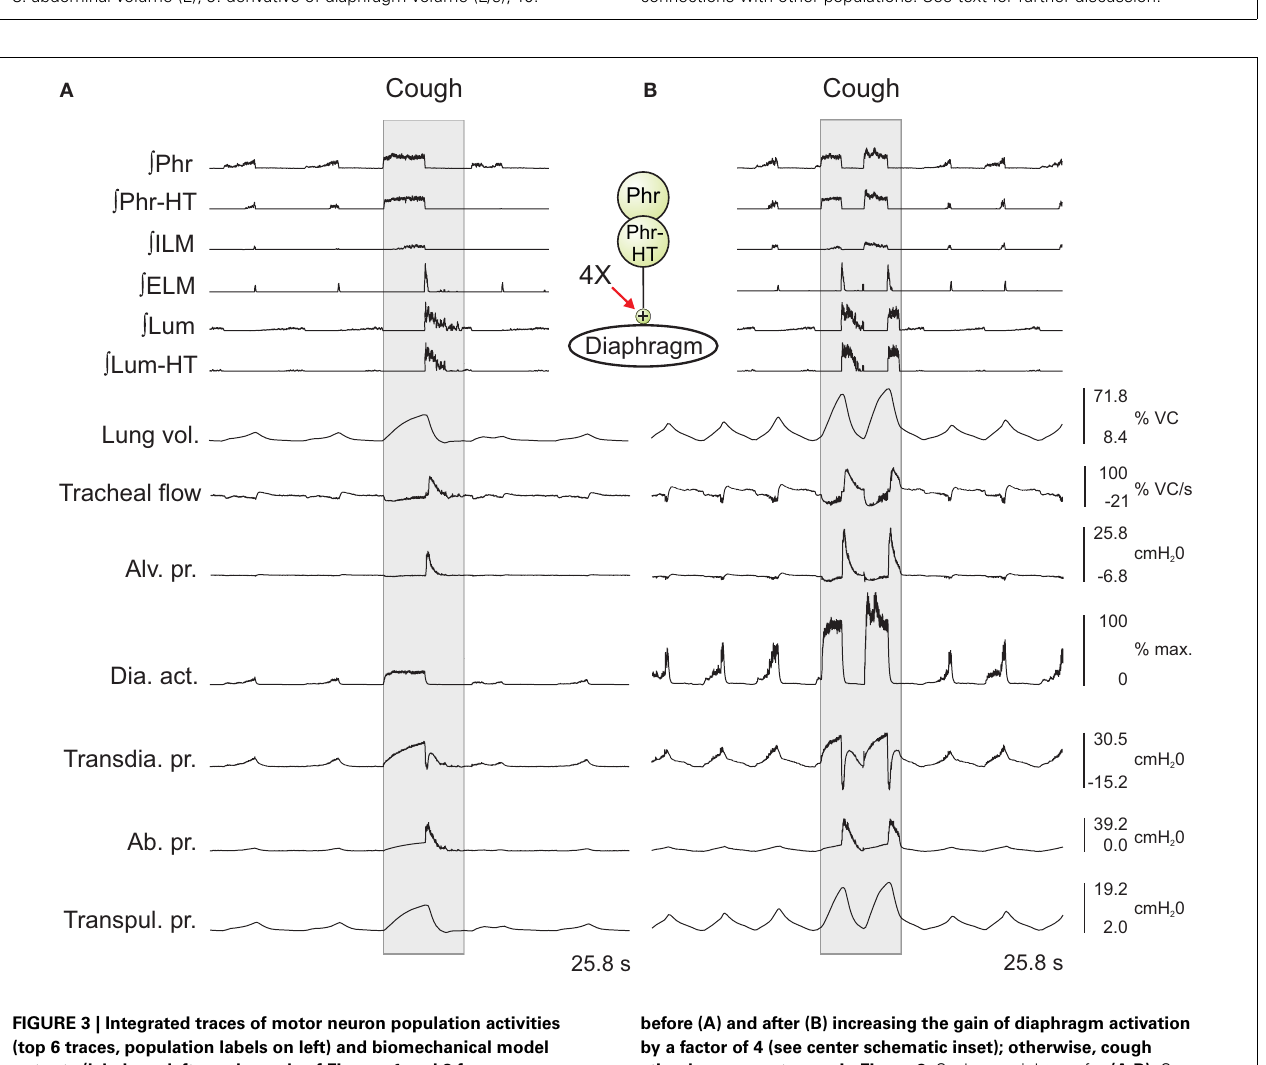
FIGURE 3 | Integrated traces of motor neuron population activities (top 6 traces, population labels on left) and biomechanical model outputs (labels on left; see legends of Figures 1 and 2 for definitions) during eupneic and “baseline” cough motor patterns